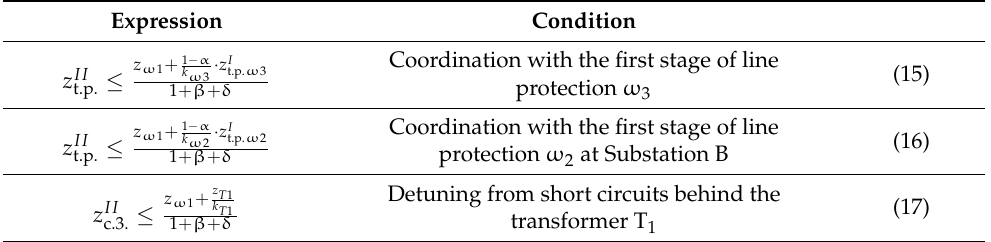
Table 2. Conditions for selecting the setting for the resistance of the second stage of distance protection.